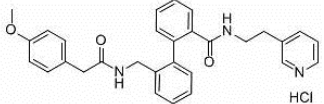
Figure 2. Structure of AVE0118.